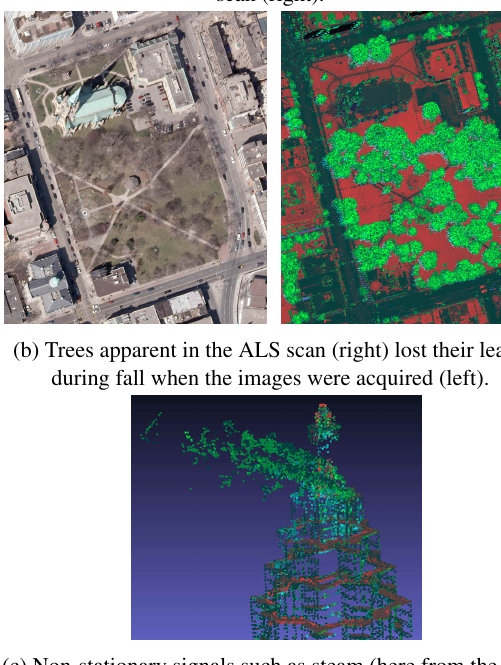
Figure 7. Differences between reference ALS data and the image-based MVS reconstruction, mostly caused by large time delay between data acquisitions 1